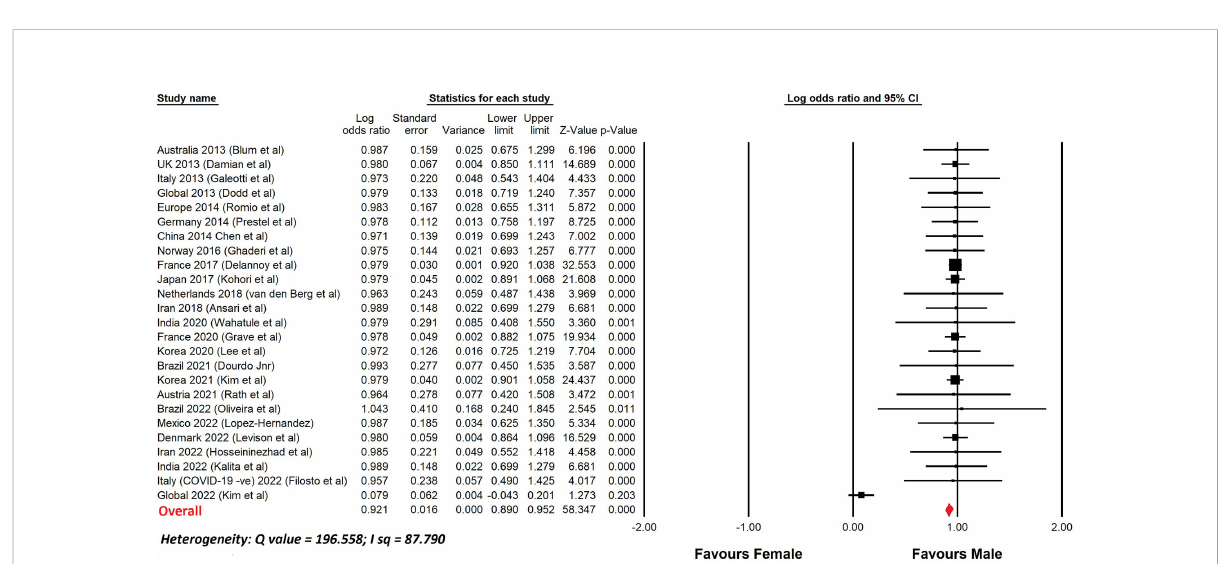
FIGURE 1 Meta-analysis of sex differences in GBS. This shows a meta-analysis of the data from Table 4. Comprehensive Meta-analysis software v 3.31 (Biotech, USA, 2022) was used. Sex differences are displayed using a log odds ratio. The overall odds ratio was 2.7. The overall relative risk was 1.6.